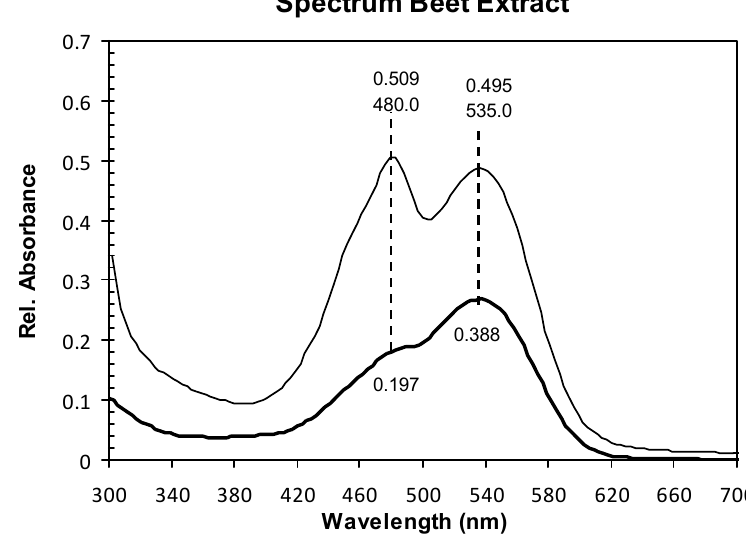
Figure 1. Absorption spectra of Beta vulgaris (BVE)/Tetraethylorthosilicate (TEOS) (thick line) and BVE (thin line), both diluted in water at pH = 3.5. Spectrum Beet Extract